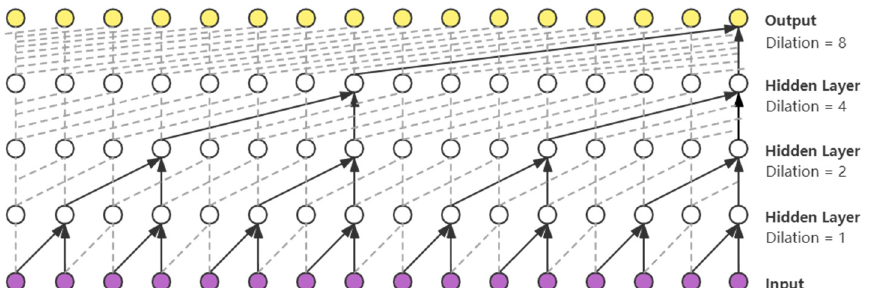
Figure 5. Visualization of a stack of dilated convolutional layers.